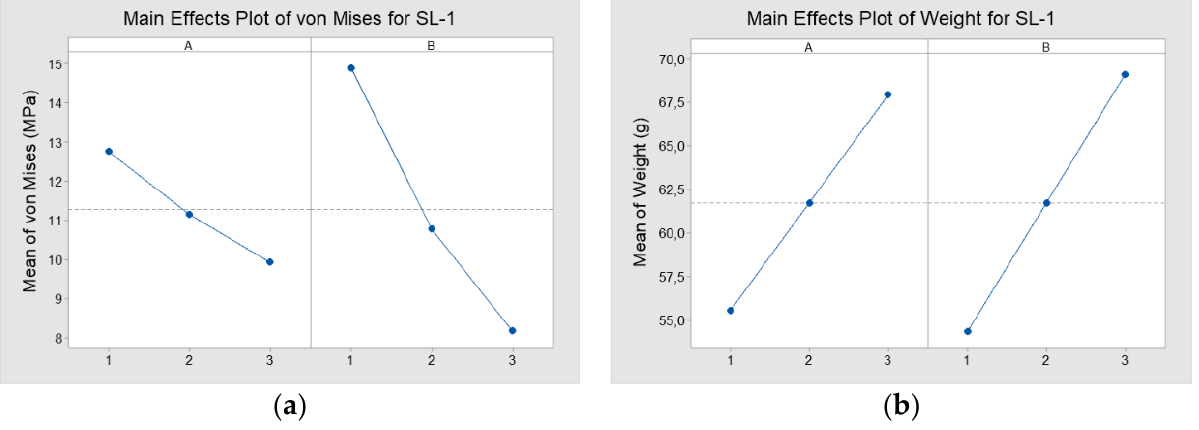
Figure 13. Study of the effect of the thickness of the first and second regions for the SL-1 structure.